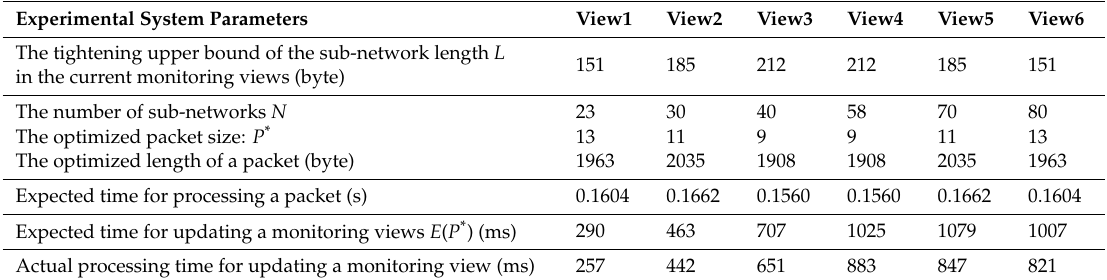
Table 2. Experimental results on optimized data packet-based communication for monitoring